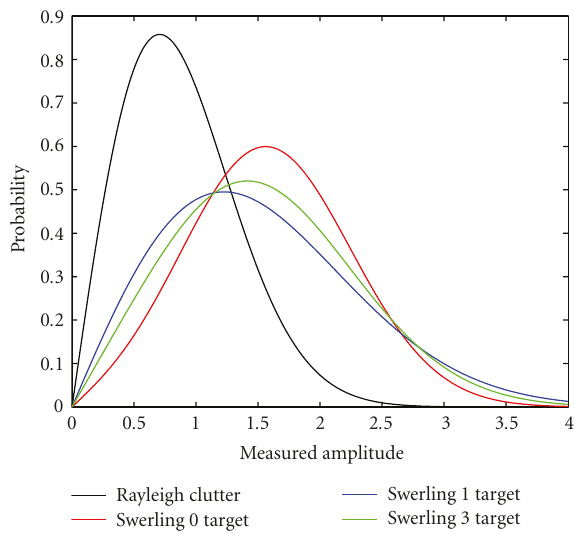
Figure 6: Sample probability distribution function curves for pure Rayleigh clutter and Swerling 0, 1, and 3 targets in Rayleigh clutter. Average target signal power is 3 dB above clutter